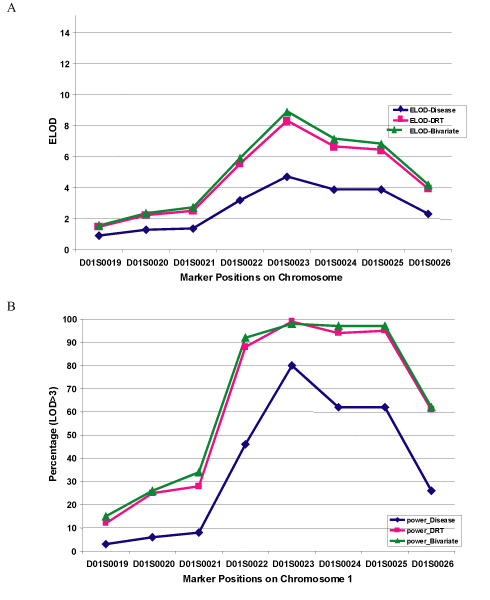
Linkage analysis of disease, DRT, and bivariate trait with the Danacaa dataset: ELOD (A) and power (percentage (LOD>3)) (B).